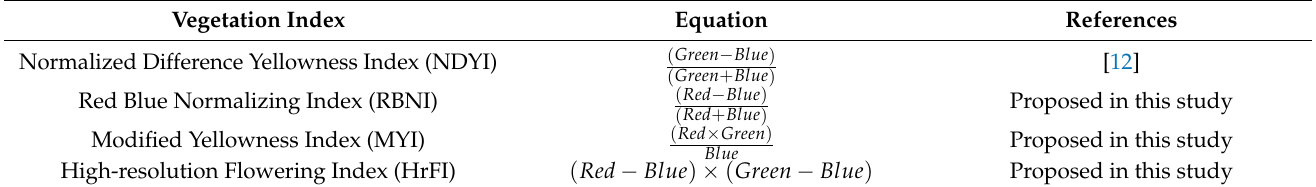
Table 1. Equations of the vegetation indices used in the